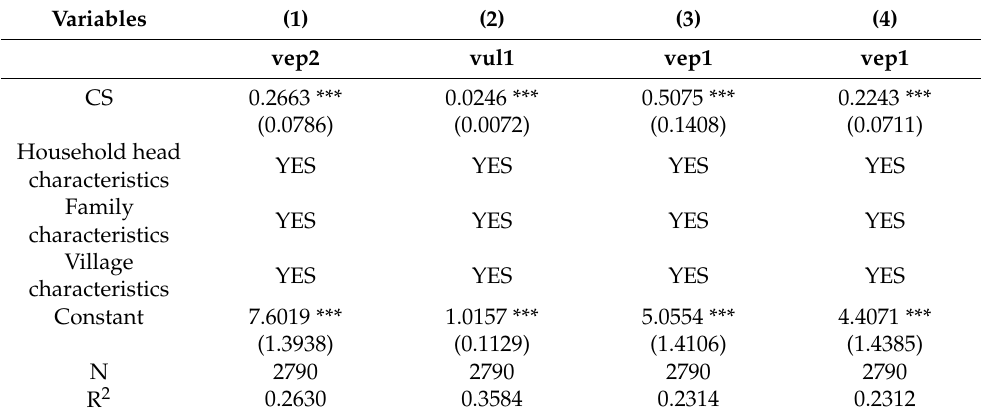
Table 4. The results of robustness tests.